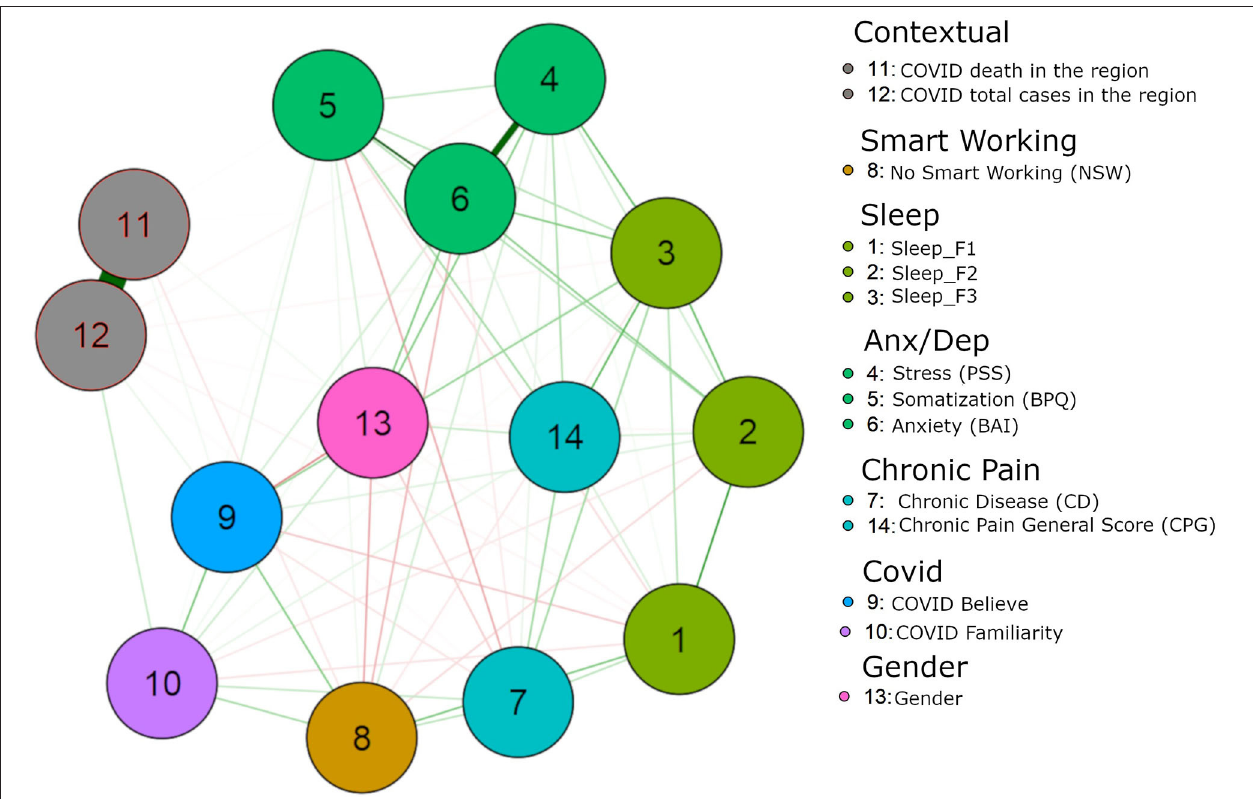
FIGURE 1 | Green lines indicate positive associations. Red lines indicate negative associations. Values are regularized partial correlations. The nodes indicate the variables as follow: 1 Sleep_F1; 2 Sleep_F2; 3 Sleep_F3; 4 PSS (Perceived Stress Scale); 5 BPQ (Body Perception Questionnaire); 6 BAI (Beck Anxiety Inventory);